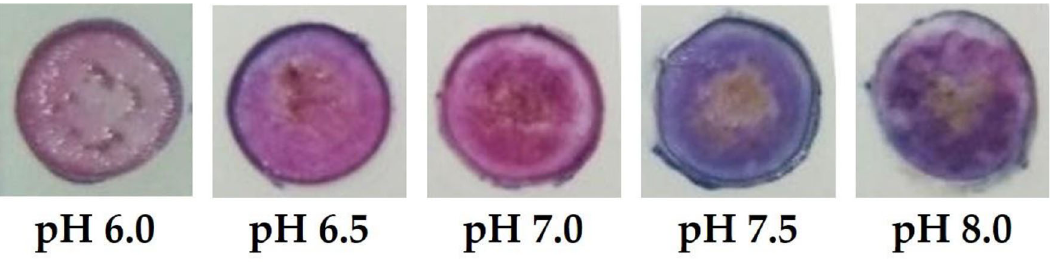
Figure 6. Optical pH sensor color changes at different pH values.